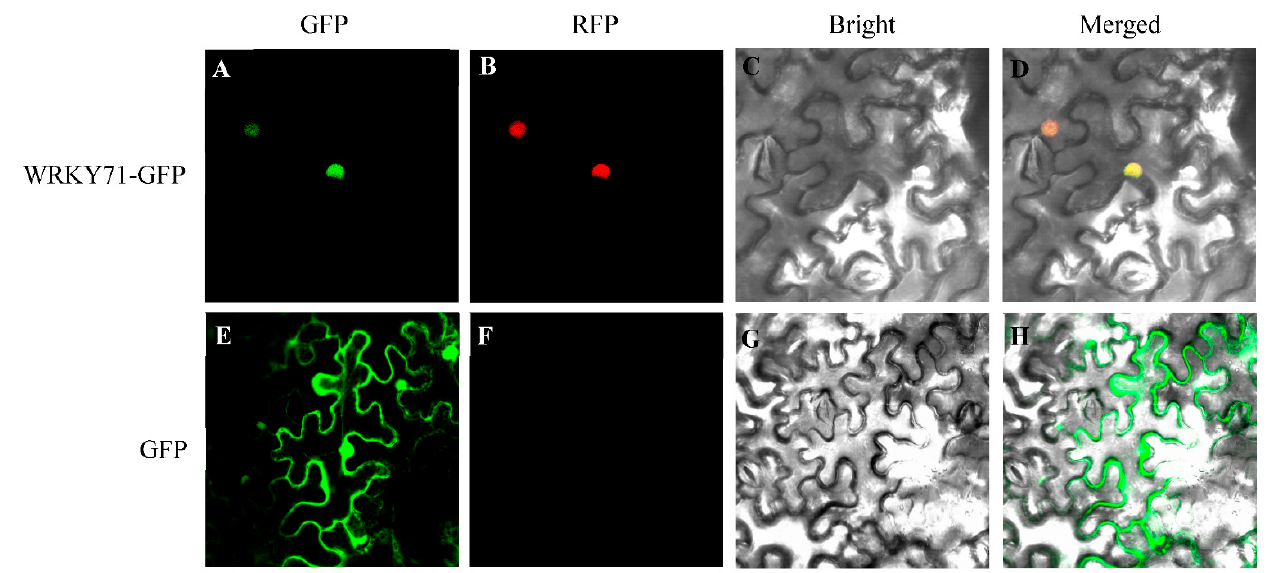
Figure 6. Subcellular localization of PhWRKY71 in Nicotiana benthamiana leaf epidermal cells. ( A , E ) Green fluorescence images of PhWRKY71-GFP protein and GFP (control). ( B , F ) Red fluorescence image of marker for nucleus localization. ( C , G ) Bright field images of PhWRKY71-GFP protein and control. ( D , H ) The merged images of PhWRKY71-GFP protein and control.